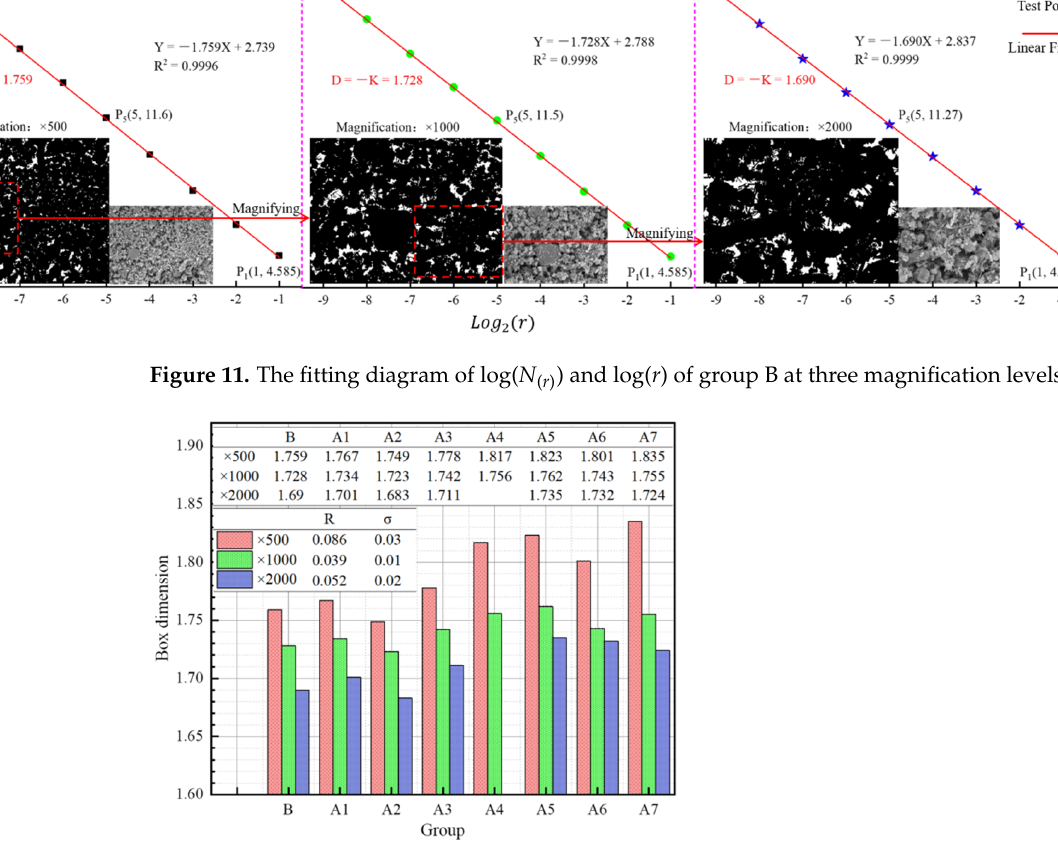
Figure 12. The box dimension of each group at three magnification levels.